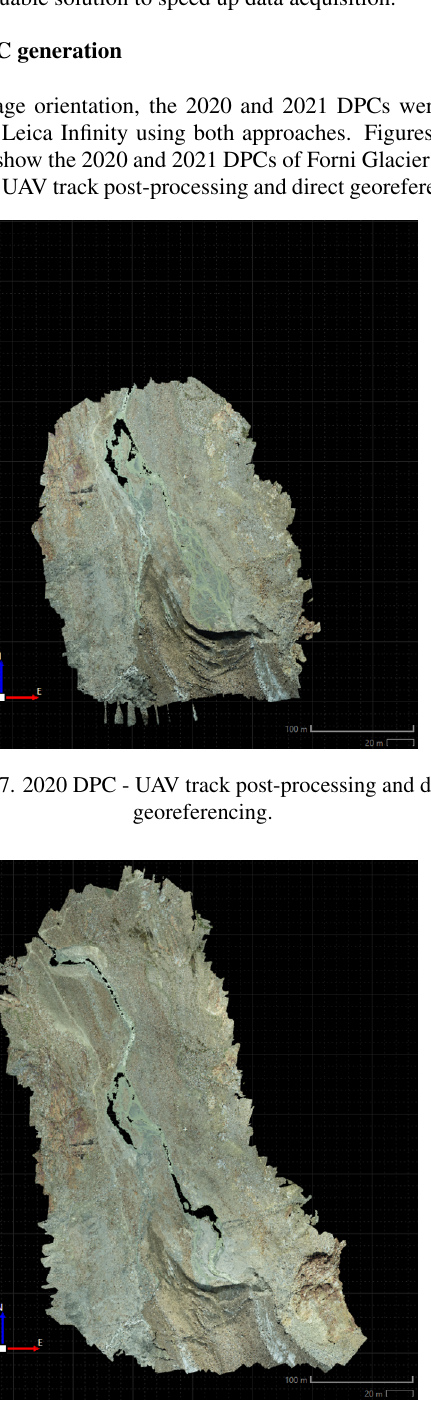
Figure 8. 2021 DPC - UAV track post-processing and direct